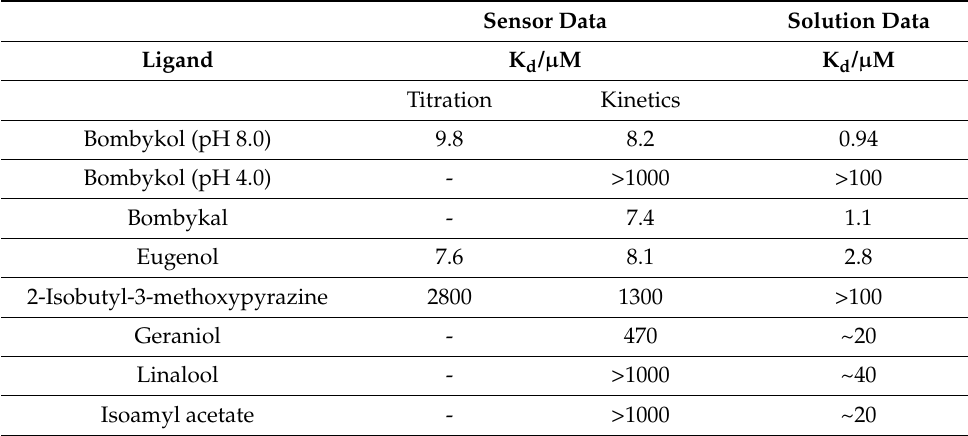
Table 1. Dissociation constants evaluated from the sensor responses, and in solution with the fluorescent competitive assay. Bombykol, bombykal, and eugenol proved to be the best ligands with both methods. Noteworthy is also the loss of binding activity at pH 4, observed not only in solution, as reported in the literature [32], but also with the immobilized